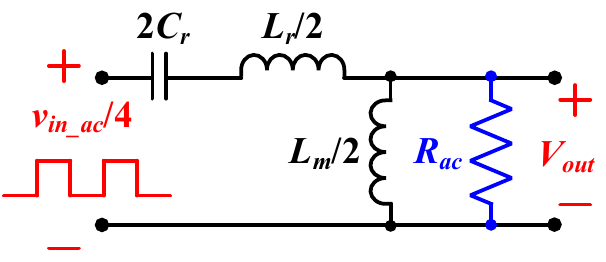
Figure 8. Equivalent circuit of Switching Pattern 4.